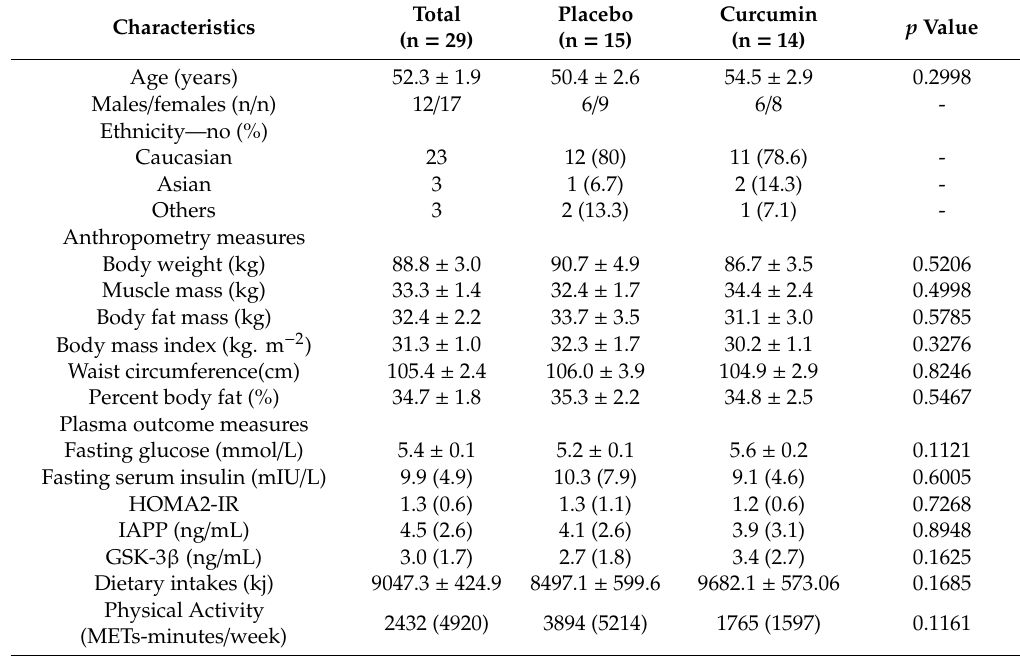
Table 1. Baseline characteristics of the trial participants.